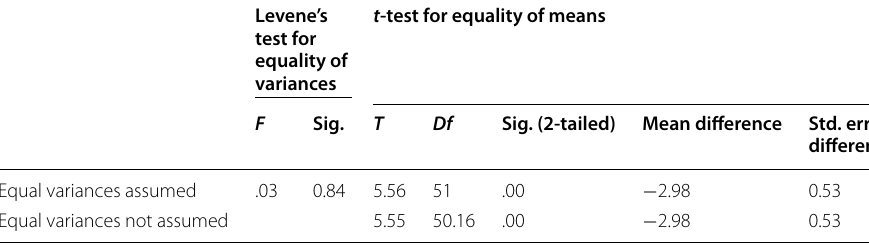
Table 4 Inferential statistics (speaking posttest of both groups)